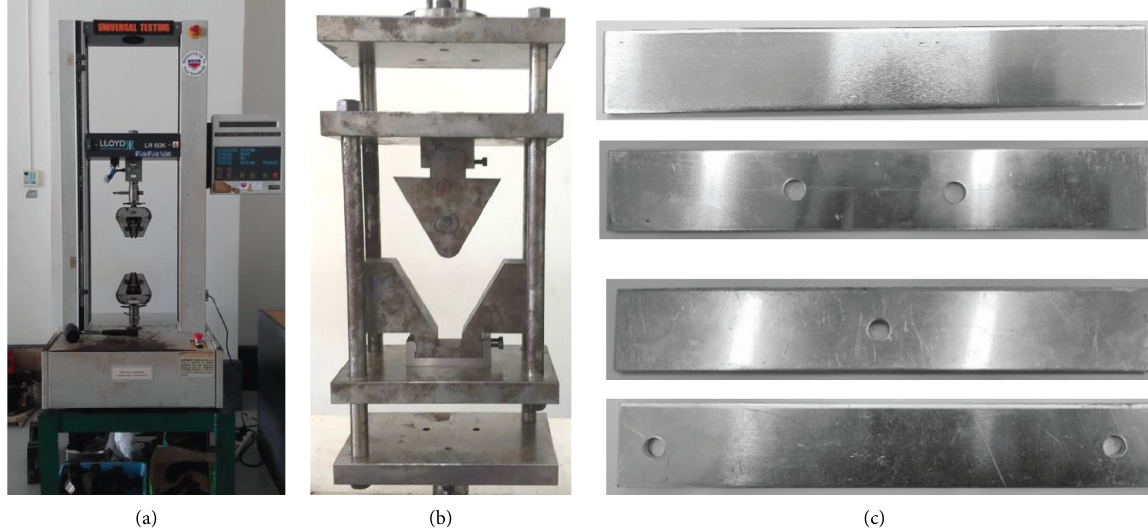
Figure 3: Machine, die set, and workpiece for experiments. (a) Press machine. (b) Die set. (c)